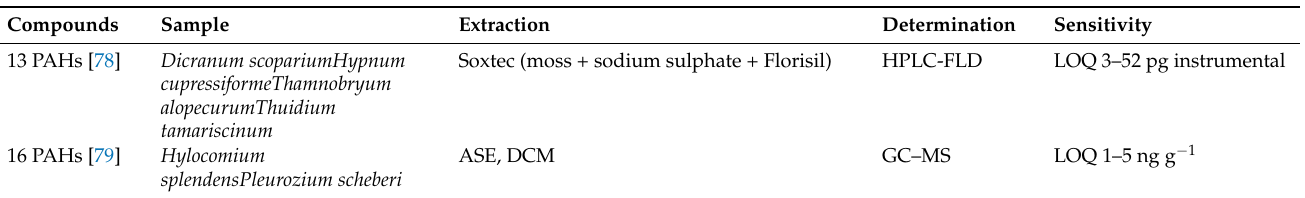
Table 3. The different methods used for the analysis of PHCs in mosses. NM: not mentioned. ASE: accelerated solvent extraction. MAE: microwave-assisted